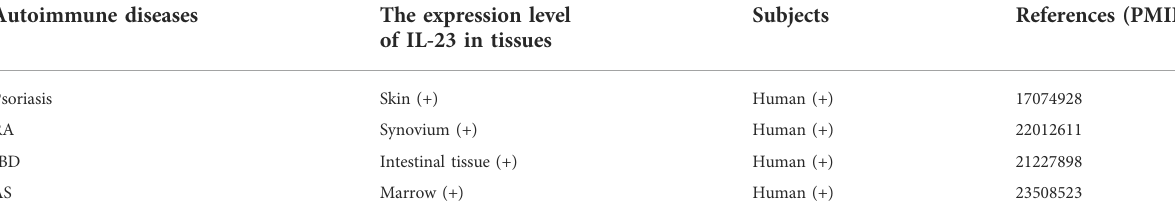
TABLE 2 The expression level of IL-23 in autoimmune disease tissues (clinical research). Autoimmune diseases